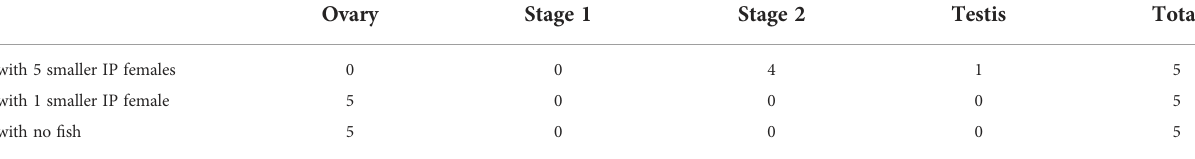
TABLE 2 Gonadal stages of IP fi sh kept with different number of smaller females.